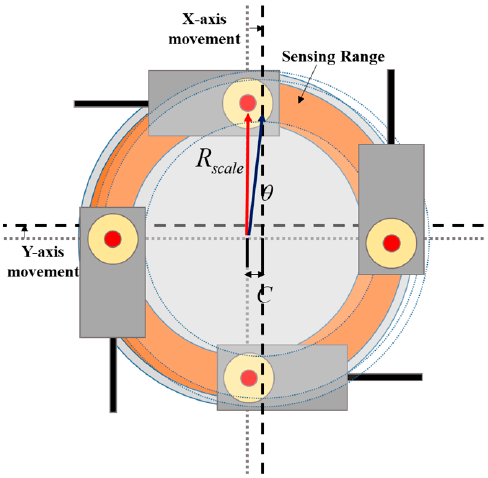
Figure 11. Sensing range of the non-contact encoders according to the X–Y axis movement.